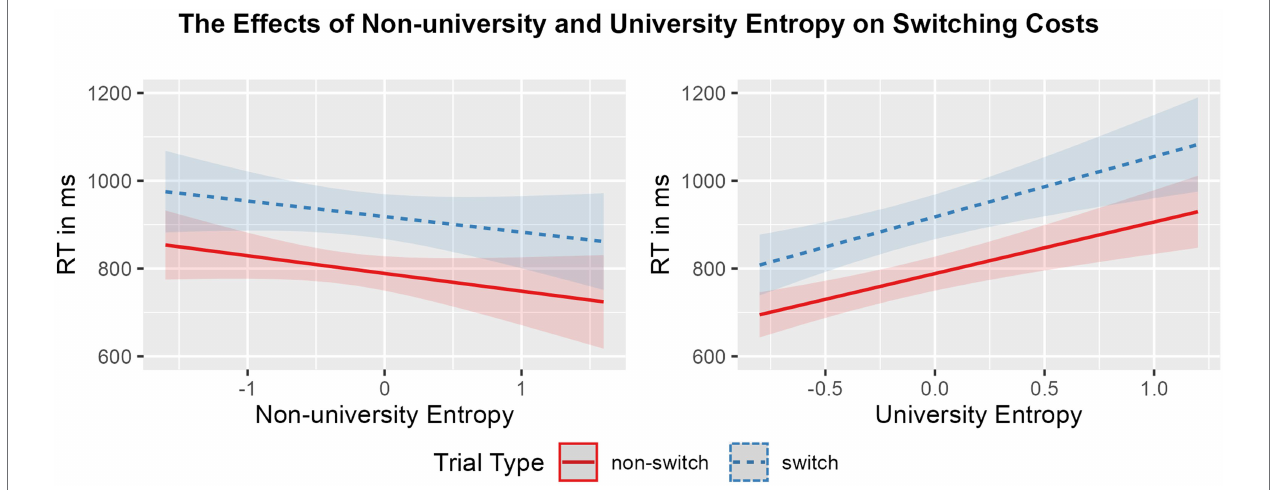
FIGURE 2 | Regression model plot of the interaction between non-university entropy ( left panel ) and university entropy ( right panel ) and trial type (blue striped: switch; red solid: non-switch) on RTs (ms). Shading represents the size of the confidence